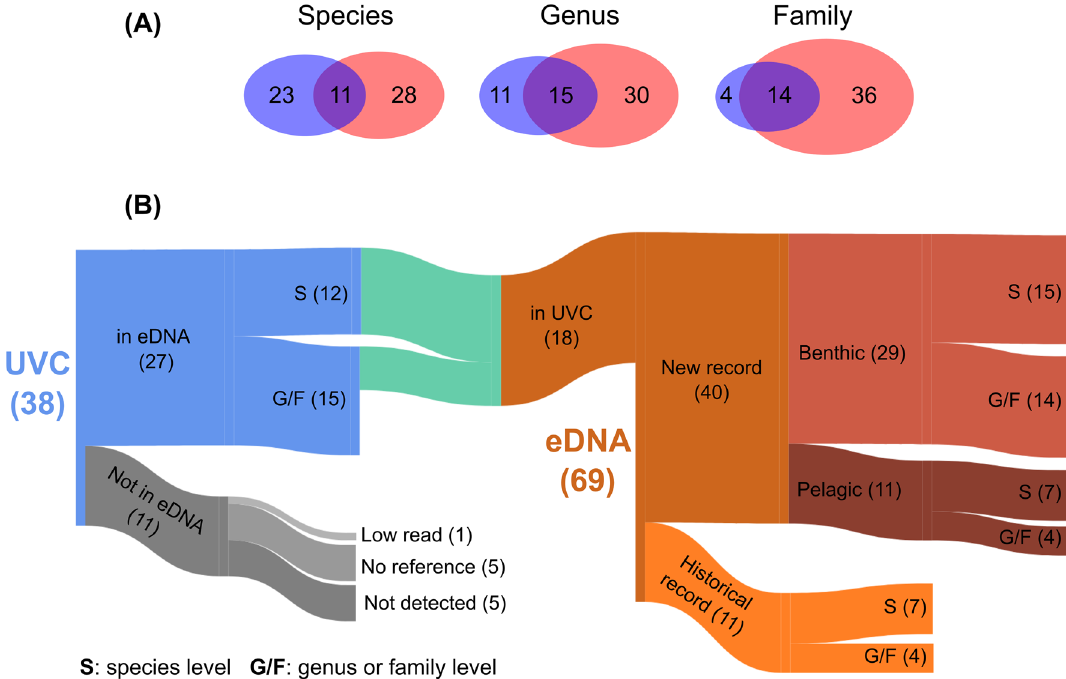
Figure 2. ( A ) Venn diagrams showing the overlap of unique fish species, genera and families detected by Underwater Visual Census (UVC: blue) and eDNA metabarcoding (red). ( B ) Sankey diagram illustrating the relationships between the 38 fish taxa detected using UVC and the 69 fish taxa detected using eDNA metabarcoding. Bar width is proportional to the number of taxa. Note that due to discrepancy in taxonomic resolution, 27 fish taxa that were visually detected were lumped into 18 taxa to match taxa from eDNA